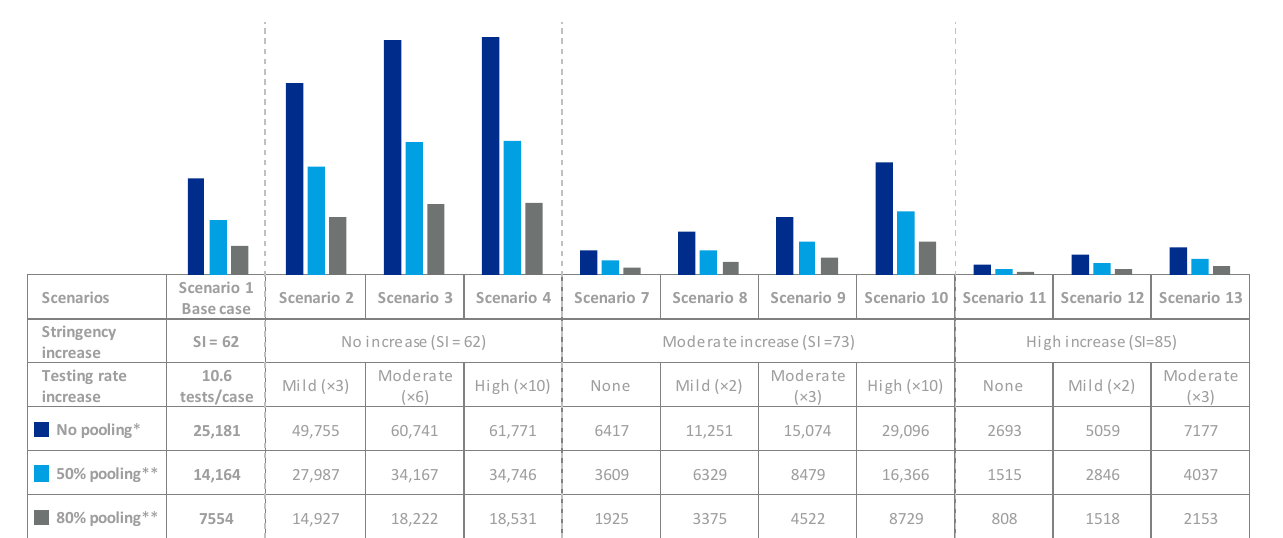
Figure 4. Pooling Costs * Re-test probability if pooling is implemented, calculated based on the prevalence of asympto- matic and pre-symptomatic individuals. M€: million €.